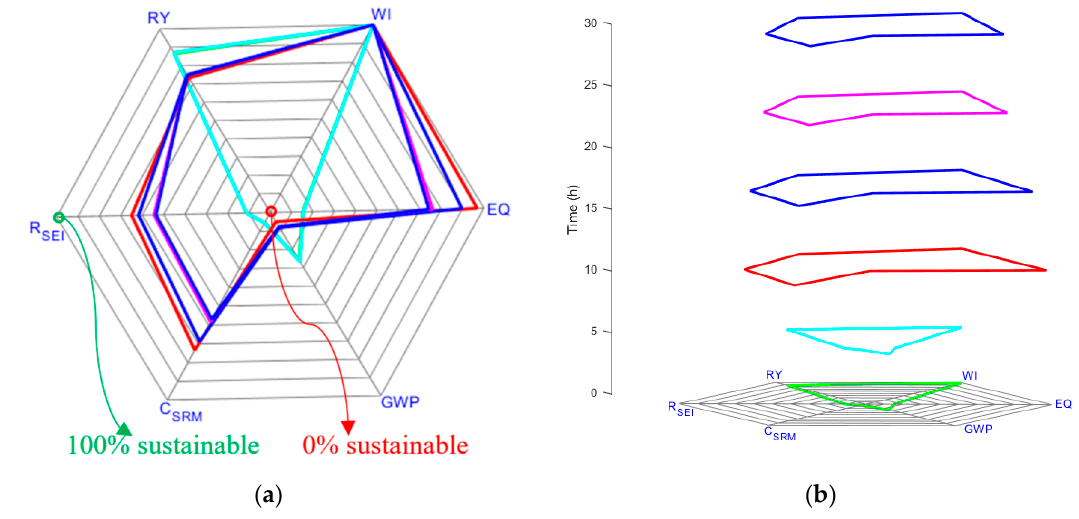
Figure 3. Visualization method for monitoring high-dimensional sustainability performance: ( a ) 2D radar plot; ( b ) 3D radar plot.